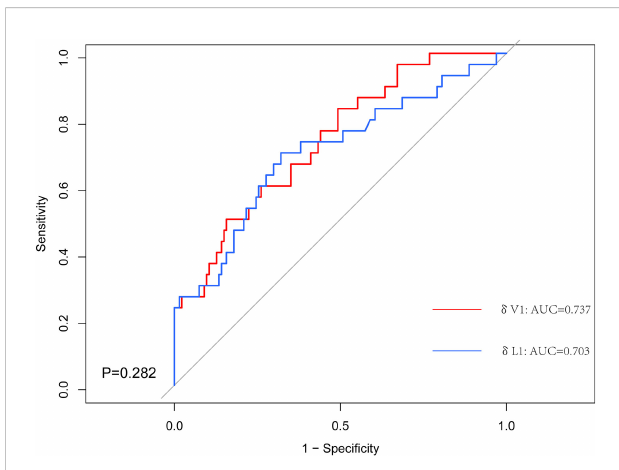
FIGURE 3 The receiver operating characteristic (ROC) curves for the d V1 and d L1. The area under the ROC curve (AUC) for d V1 was signi fi cantly higher.